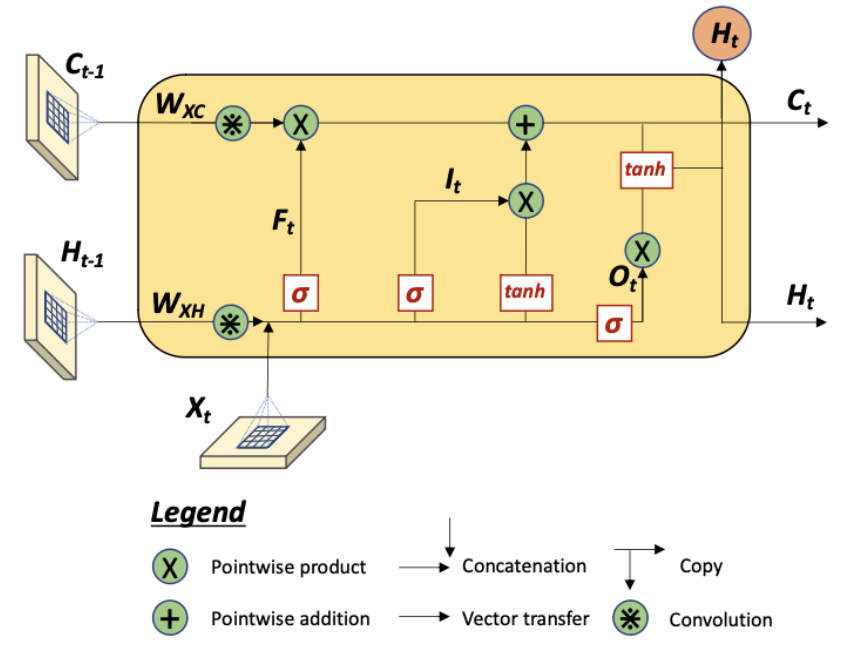
Figure 6. ConvLSTM